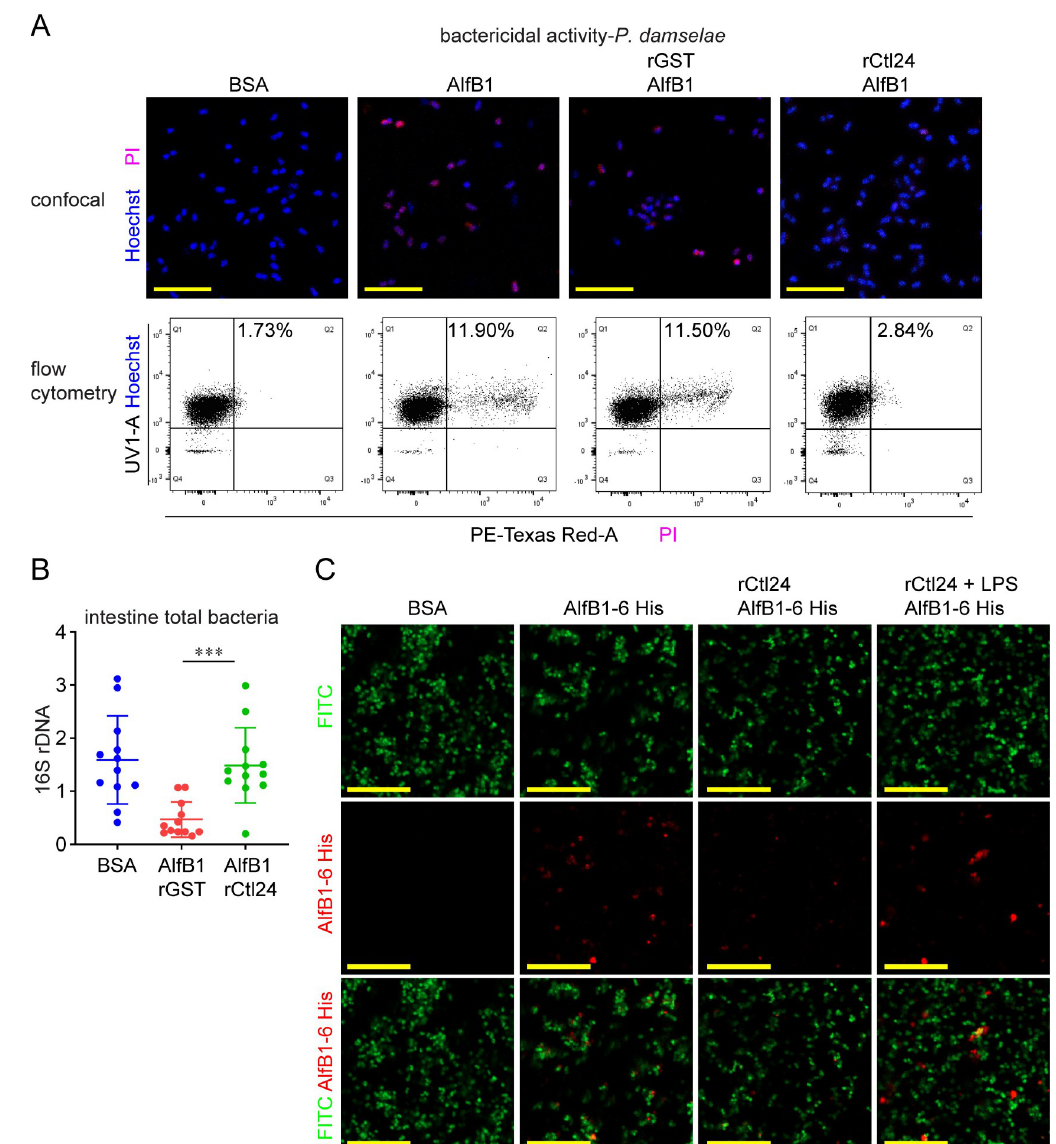
Fig 6. Inhibition of the antimicrobial activity of AlfB1 by Ctl24. (A) Inhibition of bactericidal activity of AlfB1 by Ctl24. rCtl24-pretreated P . damselae were treated with AlfB1 (5 μ M), labeled with Hoechst (staining all cells) and PI (staining dead cells), and observed using confocal microscopy or analyzed by flow cytometry. Scale bar = 10 μ m. Flow cytometry collected 10,000 events. Statistical analysis was performed by calculating Q2/(Q1+Q2) × 100%. Data are representative of three repeats. (B) Inhibition of the antimicrobial activity of AlfB1 in vivo by rCtl24. Shrimp were treated orally with indicated proteins (2 μ g). The abundance of intestine total bacteria was determined by detecting 16S rDNA using qPCR 3 d later. One dot represents three shrimp intestines. Data are representative of two repeats. ��� , p < 0.001. (C) Inhibition of the deposition of AlfB1 onto P . damselae by Ctl24. FITC-labeled bacteria (green) were pre-treated with rCtl24 in the presence or absence of LPS, and then incubated with AlfB1-6His. AlfB1 deposition was visualized by anti-6His antibodies and Dylight 549 Goat Anti-Mouse IgG (red). Scale bar = 20 μ m. Data are representative of three